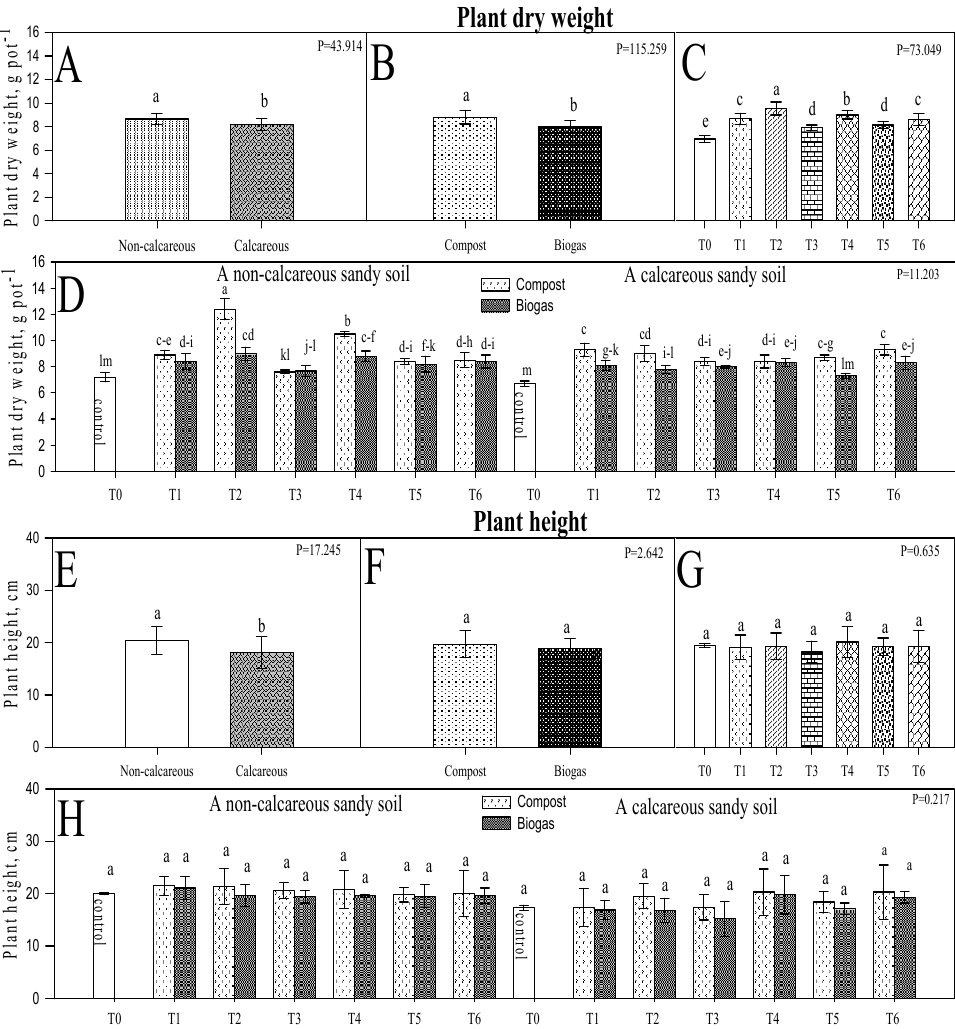
Figure 4. Dry weight (g pot − 1 ) and plant height (cm) of faba beans (mean ± SD) as affected by application of organic and mineral N- fertilizers, either solely or in different combinations. Effect of different soil types is presented in ( A , E ). Effects of different organic sources are presented in ( B , F ), while the effects of the different organic treatments are presented in ( C , G ). The interactions among the three factors of study are presented in ( D , H ). Different letters indicate significant variations among treatments.